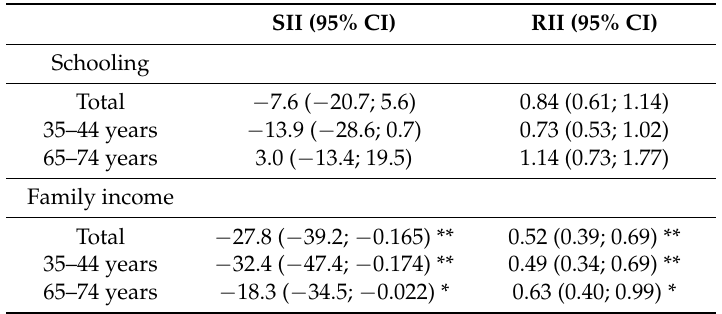
Table 3. Absolute and relative inequalities related to the negative impact of oral health on quality of life according to the socioeconomic position